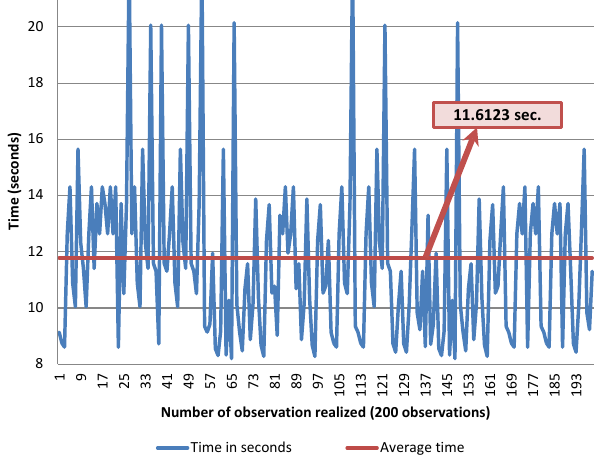
Figure 9. Average time with the thin wheel